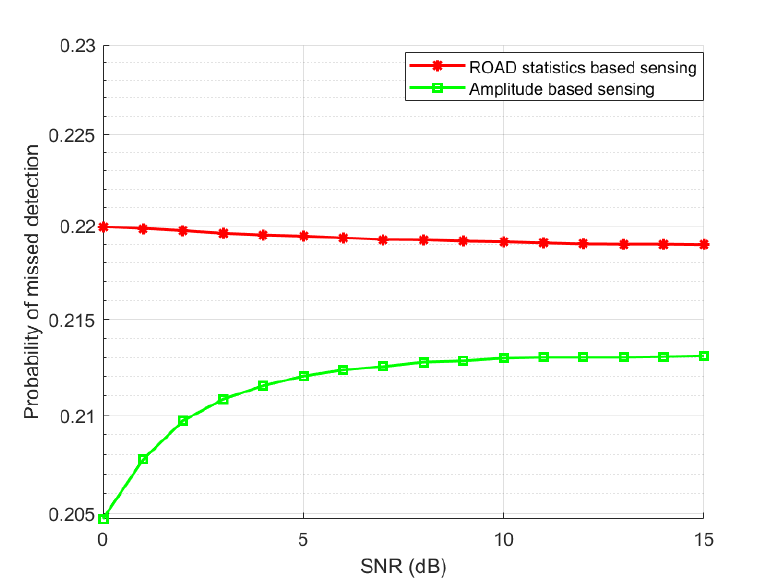
Figure 16. Probability of missed detection vs. SNR.